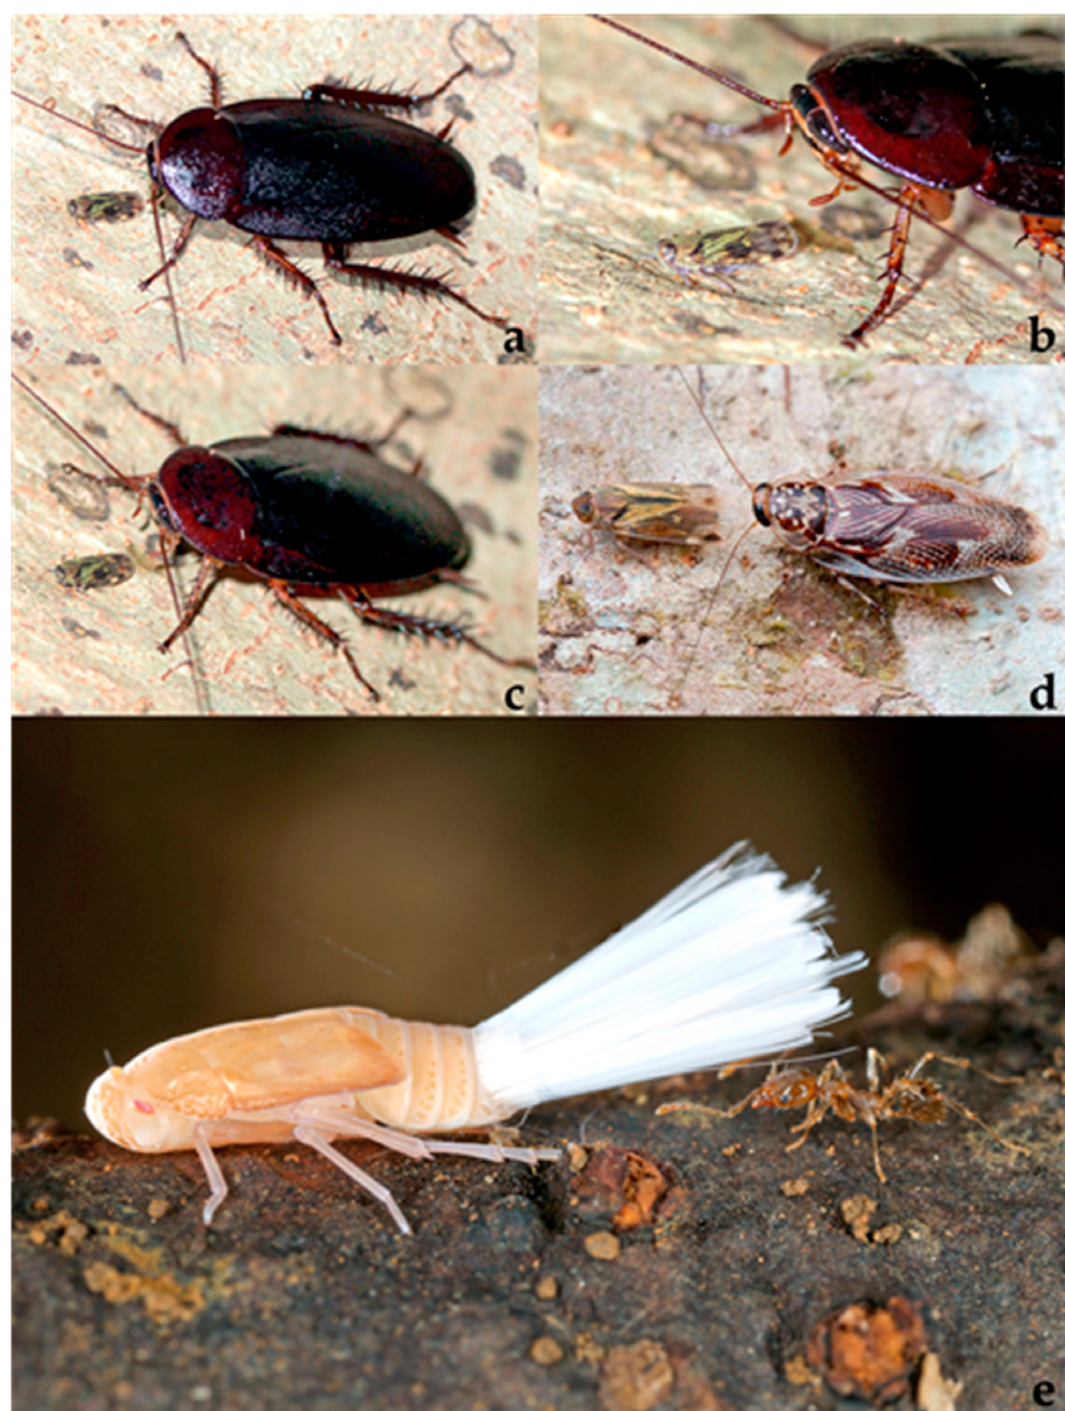
Figure 4. Cixiidae: ( a – c ) Cixiidae indet. tended by Blattodea indet., Malaysia: Sarawak, Borneo, Bako National Park, 1°43 ′ N 110°28 ′ E, 9.07.2016, adult on tree trunk, obs. X. Vermeersch; ( d ) Cixiidae indet. tended by Blattodea indet., Malaysia: Sarawak, Borneo, Selangor, 3°20 ′ N 101°30 ′ E, 05.2016, adult on tree trunk, obs. H.P. Guek; ( e ) Cixiinae indet. tended by Formicidae: Myrmicinae: Pheidole sp., Madagascar, Namoroka, 16°24 ′ 25 ″ S 45°18 ′ 47 ″ E, 139 m, 24.10.2016, nymphs on tree roots in a cave, obs. G. Kunz.